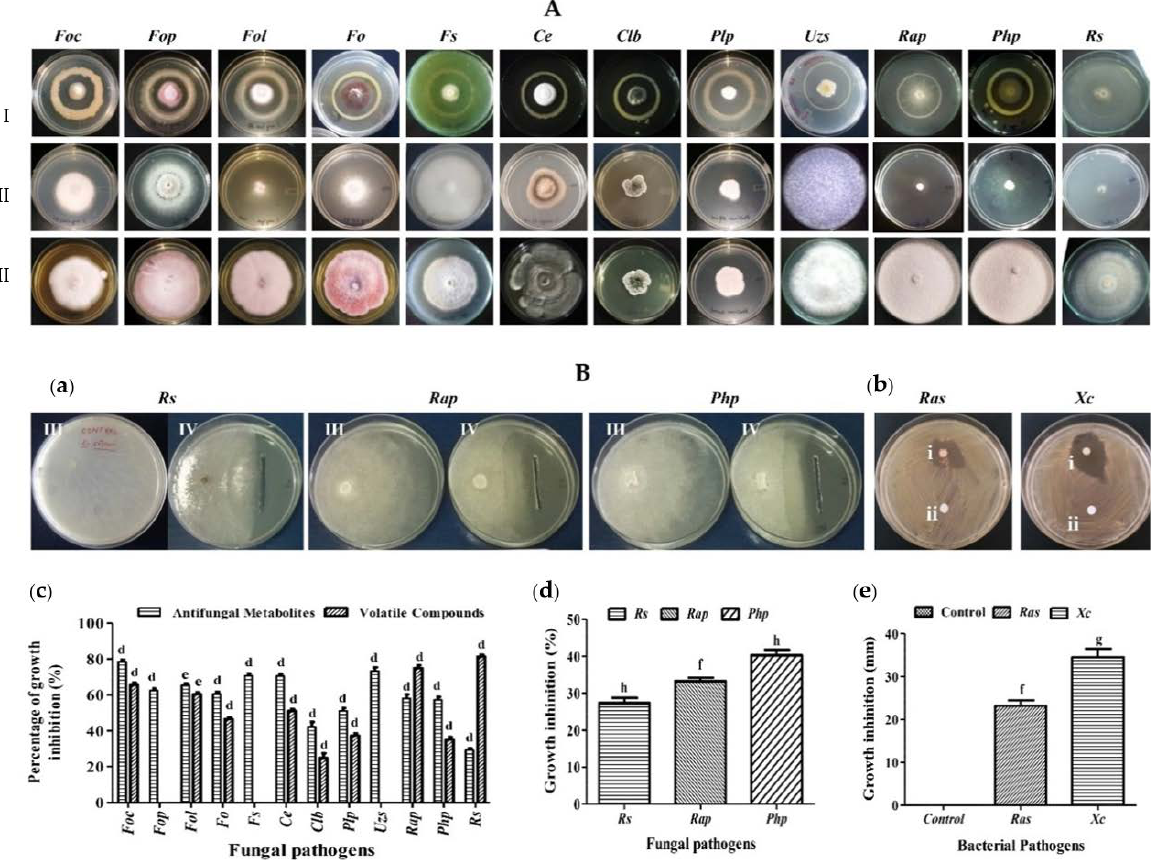
Figure 2. ( A ) A7 bacterial strain inhibits fungal plant pathogens in vitro . (I) By concentric ring dual culture bioassay method, (II) By dual plate bioassay method and (III) Control plates of all the fungal pathogens on potato dextrose agar medium at 30 ± 2 °C for a particular incubation period in three biological replicates. Control plates were the same for both experiments, performed for each fungus. Foc = Fusarium oxysporum f.sp. ciceris, Fop = Fusarium oxysporum f. sp. pisi, Fol = Fusarium oxysporum f. sp. lycopersici (Sacc.), Fo = Fusarium oxysporum, Fs = Fusarium solani (on King’s Base agar medium plate, Ce = Curvularia eragrostidis, Clb = Curvularia lunata (Wakker) Boedijn var., Plp = Phellinus lamaensis (Murrill) Pat, Uzs = Ustulina zonata (lev.) Sacc (after seven days of incubation), Rap = Rosel- linia arcuata Petch, Php = Poria hypobrunnea Petch , and Rs = Rhizoctonia solani (after two days of incu- bation). ( B ) In vitro antifungal and antibacterial activity of cell - free supernatant (CFS) of A7 against plant fungal and bacterial pathogens. (a) By agar well diffusion method and (b) by agar disk diffu- sion method on Potato Dextrose Agar and King’s Base agar medium plates at 30 ± 2 °C in three biological replicates. III = Control and IV = Agar well containing 100 µL of CFS on each plate. Rs = Rhizoctonia solani, Rap = Rosellinia arcuata Petch and Php = Poria hypobrunnea Petch . Ras = Ralstonia sol- anacearum and Xc = Xanthomonas campestris (i = agar disc containing 50 µL of CFS and ii = control with 50 µL of sterile double distilled water) after two days of the incubation period. (c) = Bar dia- gram showing the Percentage of growth inhibition by A7 against plant fungal pathogens by pro- ducing antifungal metabolites and volatile compounds. Values are expressed as means (n = 3) ± Standard Error Mean (SEM). Statistical differences were analyzed using a Two-way analysis of var- iances (ANOVA). Significant differences (d = p < 0.001, e = p > 0.05 followed by Bonferroni Posttests) compared with antifungal metabolites vs. volatile compounds. (d) = Bar diagram showing the per- centage of growth inhibition by the CFS of A7 against plant fungal pathogens and (e) = Bar diagram showing growth inhibition of bacterial plant pathogens (calculated as millimeter - scale). Values are expressed as means (n = 3) ± Standard Error Mean (SEM). Statistical differences were analyzed using